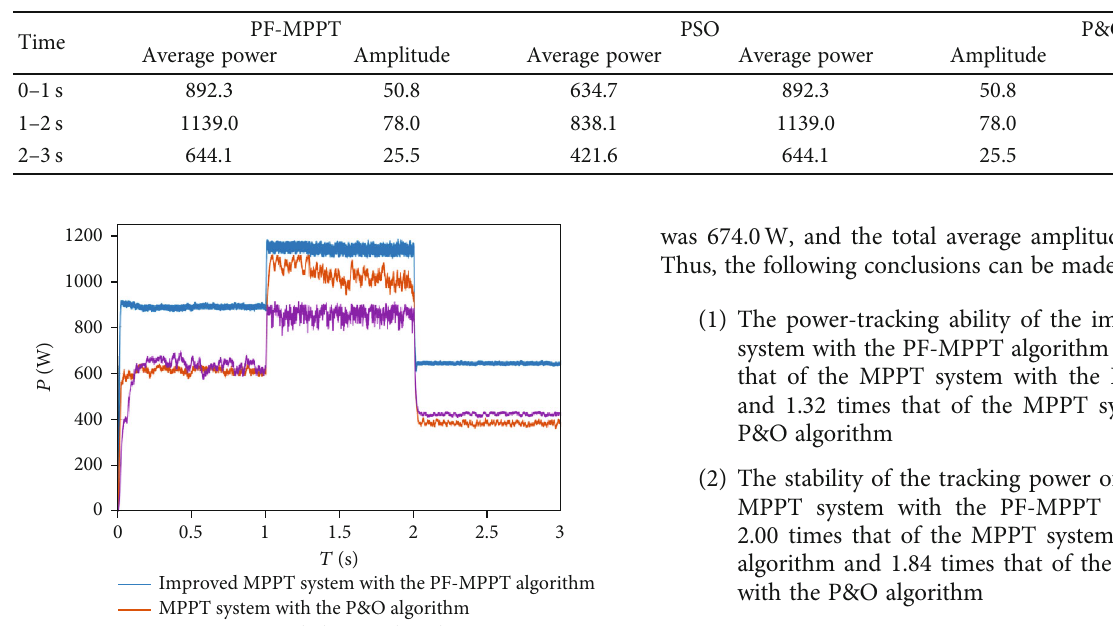
Table 6: Average power and amplitude values at the operating point (unit: W).